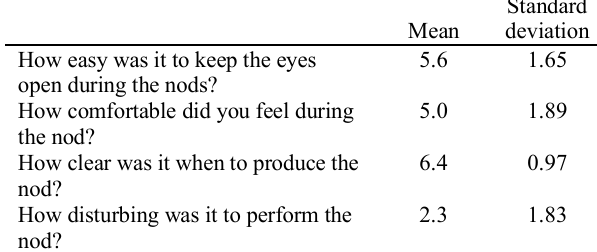
Table 3. Differences of recording durations in seconds of mocap system and eye tracker between beginning and end nod per trial and average per participant.